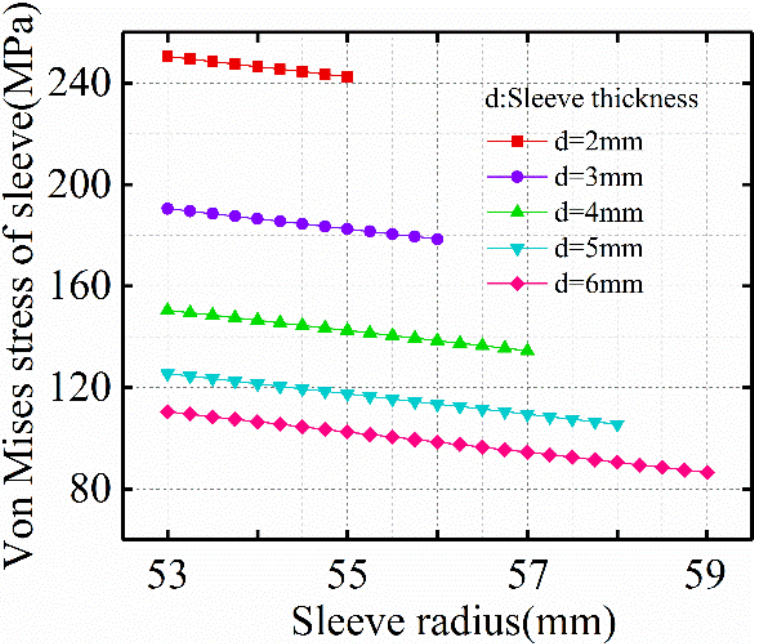
Figure 19. Influence of sleeve thickness on sleeve Von-Mises stress.